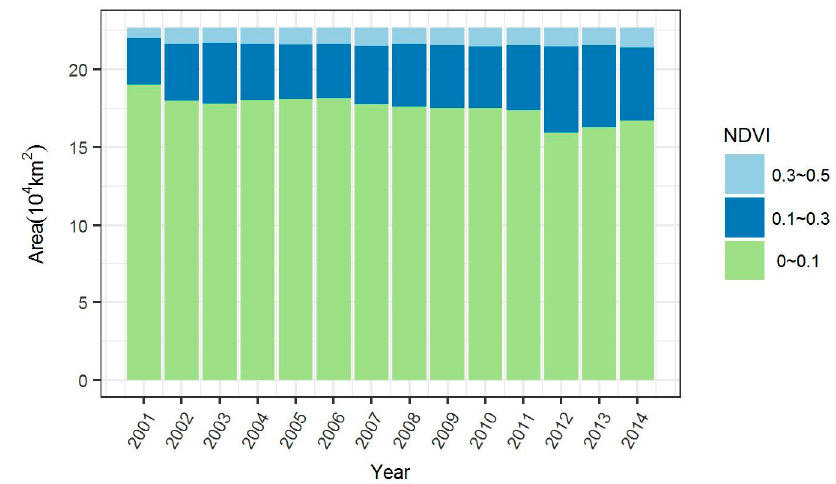
Figure 7. Variations in the areas with different NDVI ranges (>0.1) from 2001 to 2014 over the study region.